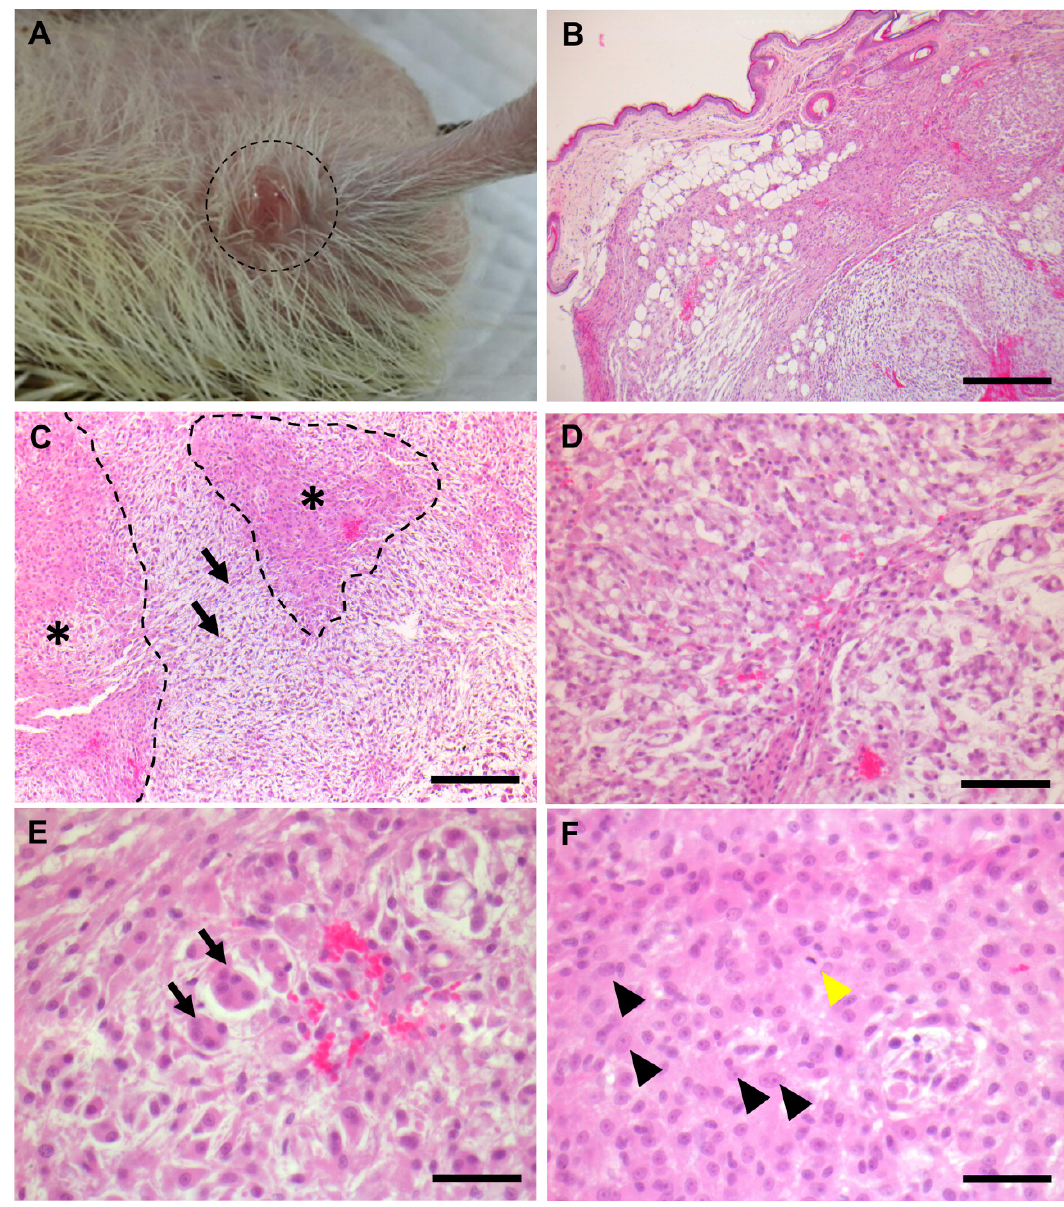
Figure 1. Pathological observation of the pleomorphic myxoid liposarcoma. ( A ) Gross observation with gross pathology. The neoformations were protrude and dome-shaped. ( B ) Microscopic observations of low magnification. The neoformations were located in the subcutaneous layer of the right abdomen. The neoformations were not encapsulated. Scale bar = 500 µ m. ( C – F ) Microscopic observations of high magnification. ( C ) The neoformations were composed of the myxoid proliferation area (black arrows) and cellular area (outlined and marked with asterisks). The myxoid proliferation area is composed of proliferating stellate cells and abundant myxoid materials. Scale bar = 200 µ m. ( D ) Neoplastic adipoblasts with variable size of intracytoplasmic clear vacuoles. Scale bar = 100 µ m. ( E ) Large bizarre multinucleated giant cells (arrows). Scale bar = 50 µ m. ( F ) Mitotic figures were sometimes observed (yellow arrowhead). Epithelioid cells were observed (black arrowheads). The epithelioid cells had abundant eosinophilic cytoplasm with round-to-oval-shaped nuclei. One to two prominent nucleoli were observed in the nucleus. Scale bar = 50 µ m.